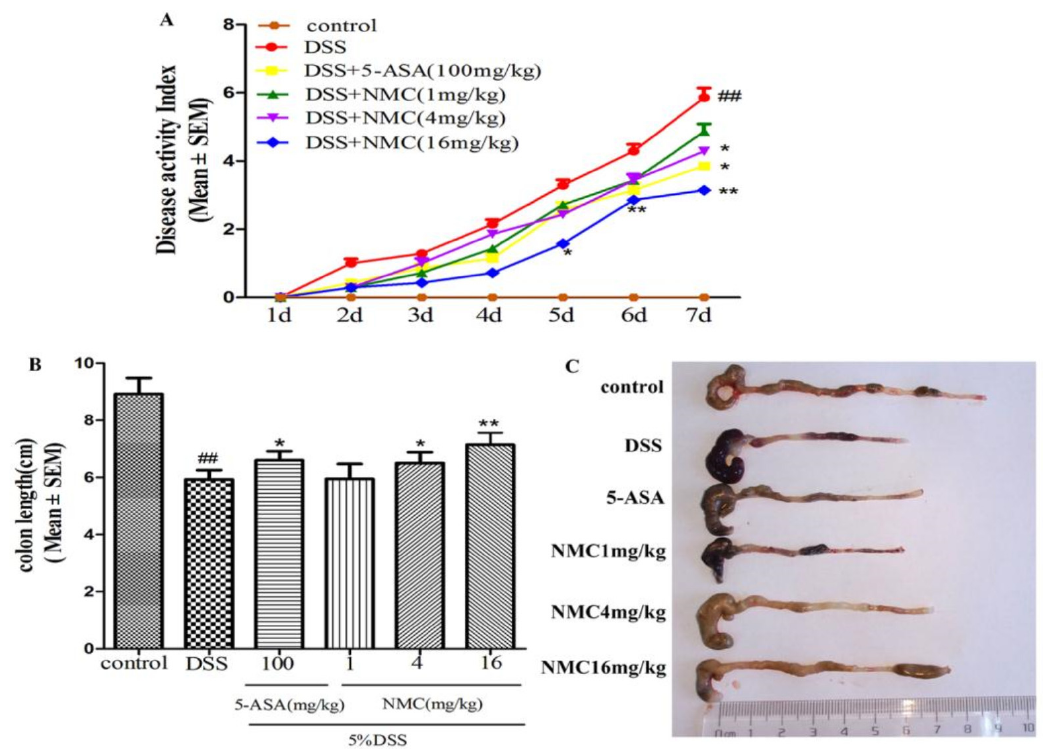
Figure 2. NMC ameliorates clinical signs of DSS-induced acute murine colitis. ( A ) Effects of different doses of NMC and 5-ASA on DAI in DSS-induced experimental colitis in mice. ( B ) Effects of NMC on DSS-induced changes in colon length and ( C ) macroscopic appearances. Data are expressed as mean ( n = 10 per group) ± SEM. ## p < 0.01 compared with control group; * p < 0.05, ** p < 0.01 compared with the DSS-vehicle group.